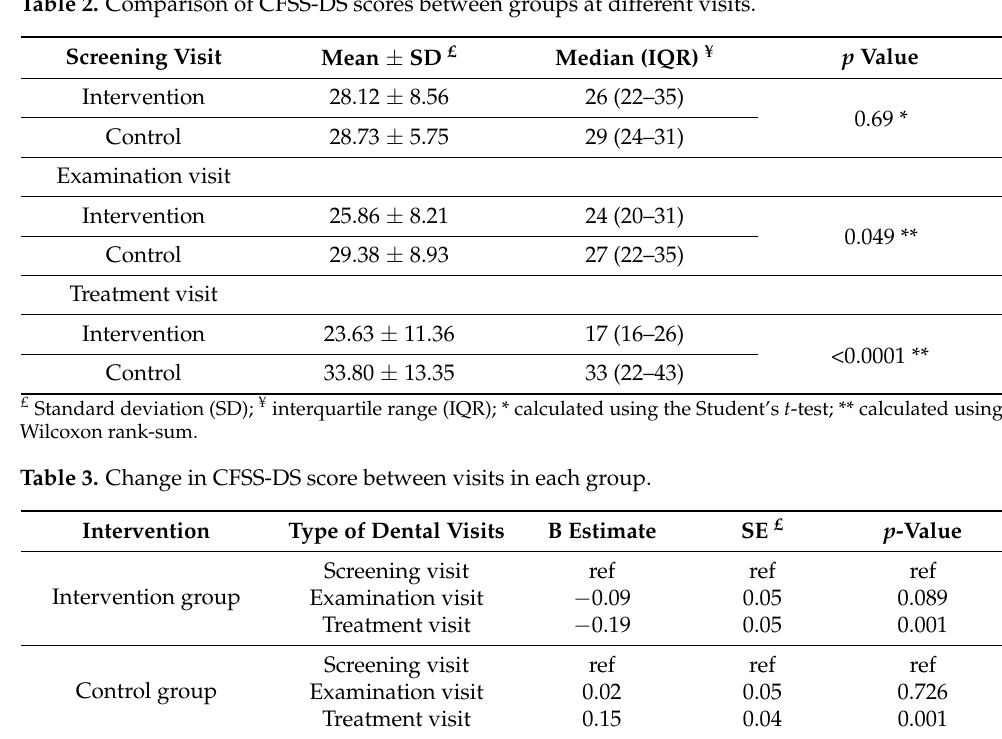
Table 2. Comparison of CFSS-DS scores between groups at different visits.